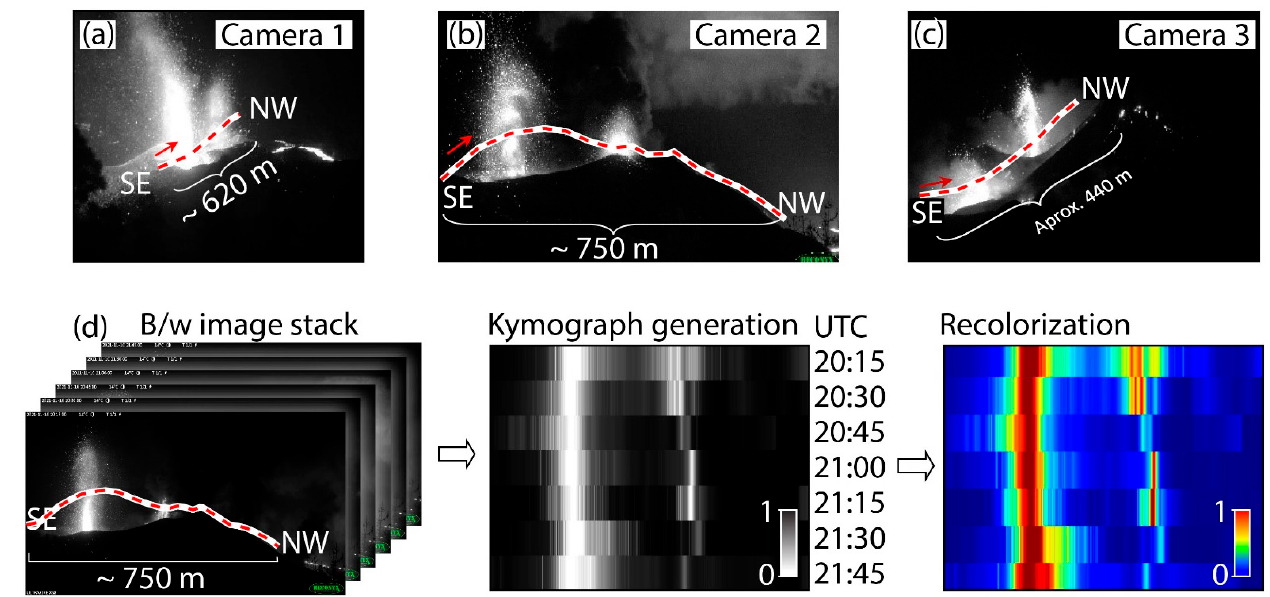
Figure 3. Camera views and profiles. ( a ) Camera 1 view from 1500 m distance to the NW, ( b ) camera 2 view from 500 m distance to the SW, and ( c ) camera 3 view from 140 m distance to the NW. The red line represents the profile generated for the different camera views to extract the pixel values for further processing. All of the profiles were extracted from SE to NW. ( d ) Kymograph generation demonstration for camera 2 dataset. There is a series of nighttime images organized chronologically in the left image. The red line shows the profile used to extract the pixel values from SE to NW. The extracted pixels are stacked together in chronological order in the right image. Two lava fountains were active during this hour and a half. The left lava fountain was active during this period, while the right one was active only for the first 45 min.